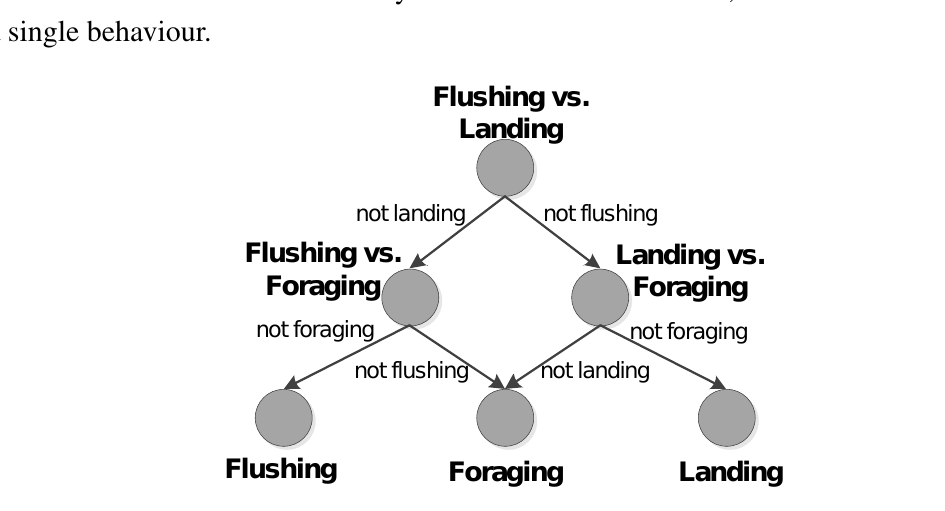
Table 2. Confusion matrix obtained from the classification of the three behaviours, using SVM with a six dimensional feature vector and RBF kernel function. The bold numbers indicate correct classification. The samples are 100 ms audio sequences. The notation A/B refers to the notation Test A and Test B, described in the Section 2.7. A: Classification where data has been divided based on date; B: Classification where data has been